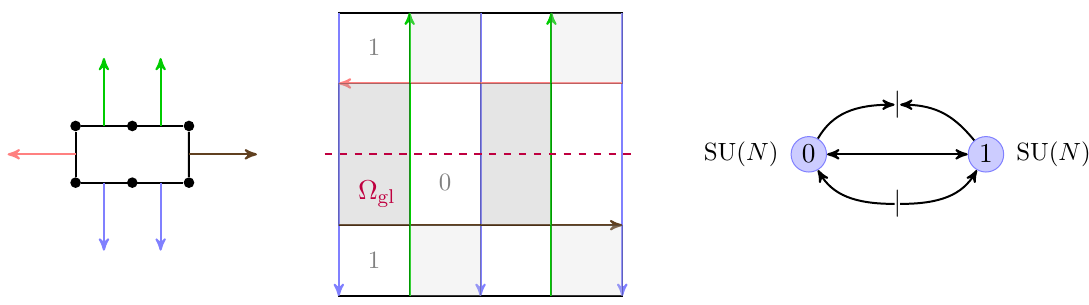
Figure 24. The model L 1 , 1 , 1 / Z 2 . On the left the toric diagram is drawn, at the center the five-brane and its glide projection, on the right the quiver resulting from the orientifold